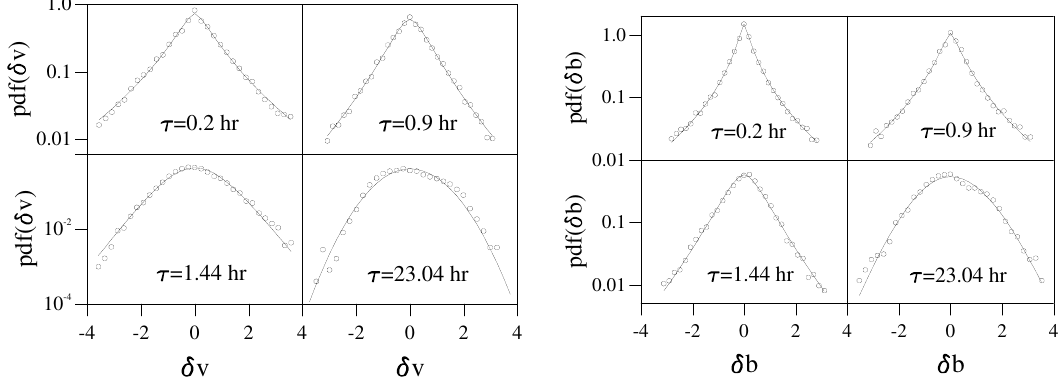
Figure 94: Left: normalized PDFs of fluctuations of the longitudinal velocity field at four different scales 𝜏 . Right: normalized PDFs of fluctuations of the magnetic field magnitude at four different scales 𝜏 . Solid lines represent the fit made by using the log-normal model. Image reproduced by permission from Sorriso-Valvo et al. (1999), copyright by